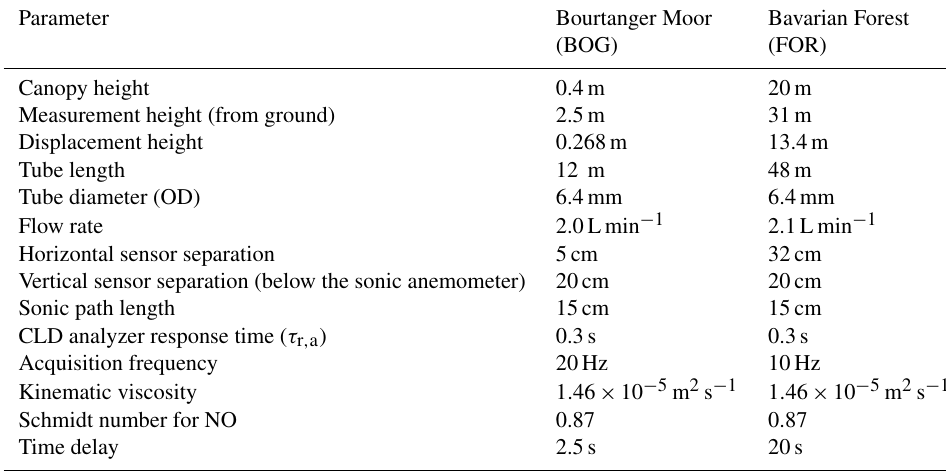
Table 1. Physical parameters of the EC setups. Parameter